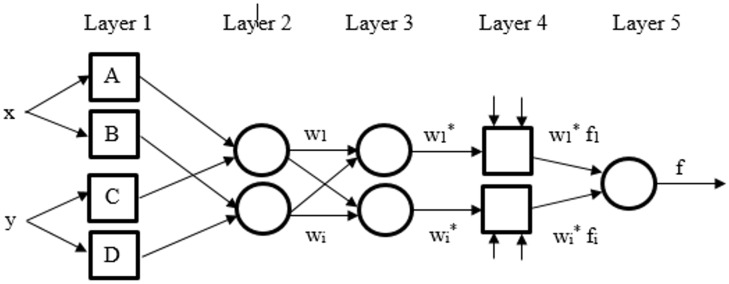
ANFIS structure.